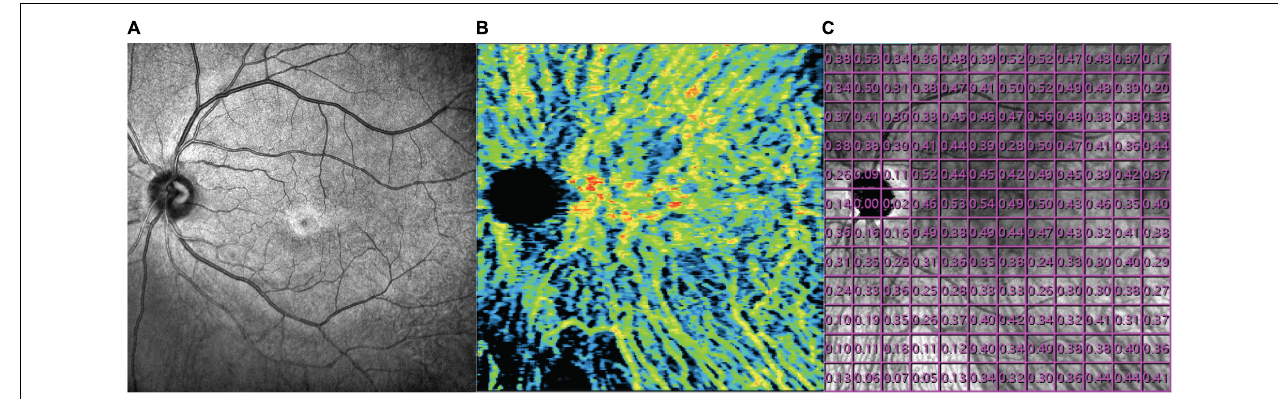
FIGURE 1 | Example of a SLO image (A) , choroidal vascularity index image (middle), and the detailed CVI values of each 1 * 1 mm grids (B) from the fellow eye (C) of a enrolled BRVO